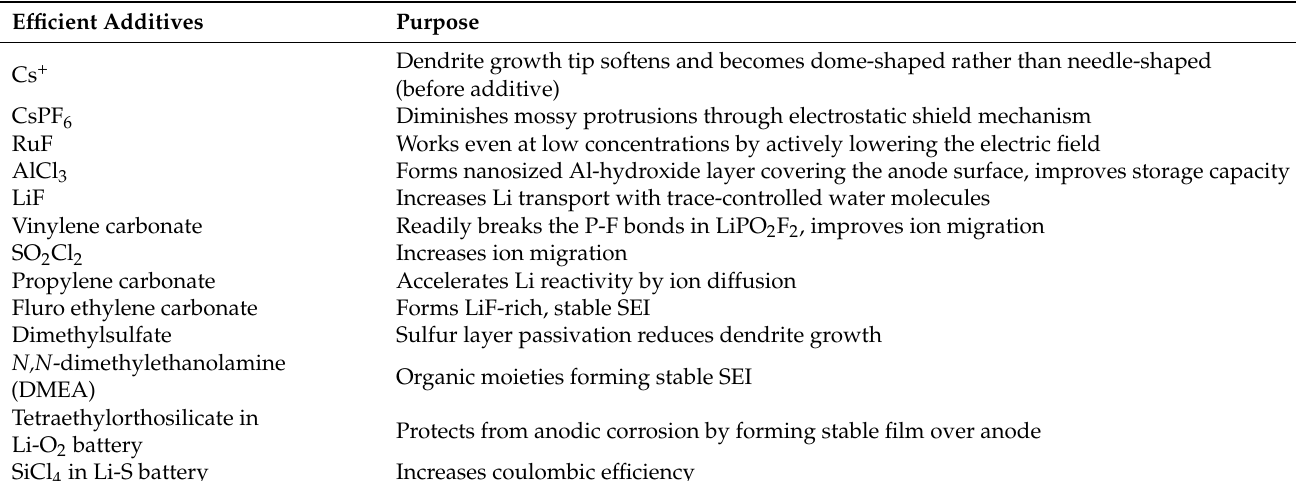
Table 6. Common additives and their